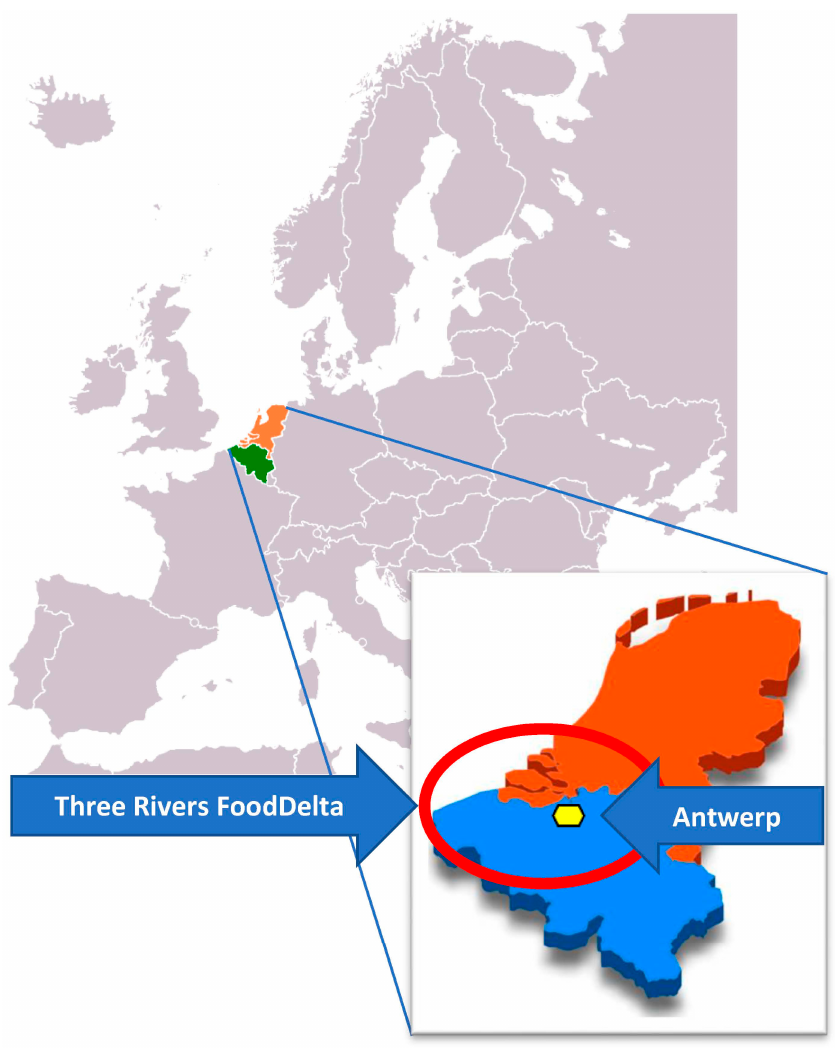
Figure 1. Location of Antwerp in the Three Rivers FoodDelta. Reprinted with the permission of: Center for Gastrology and Primary Food Care, 3000 Leuven, Belgium. 2022, Bart Geurden.